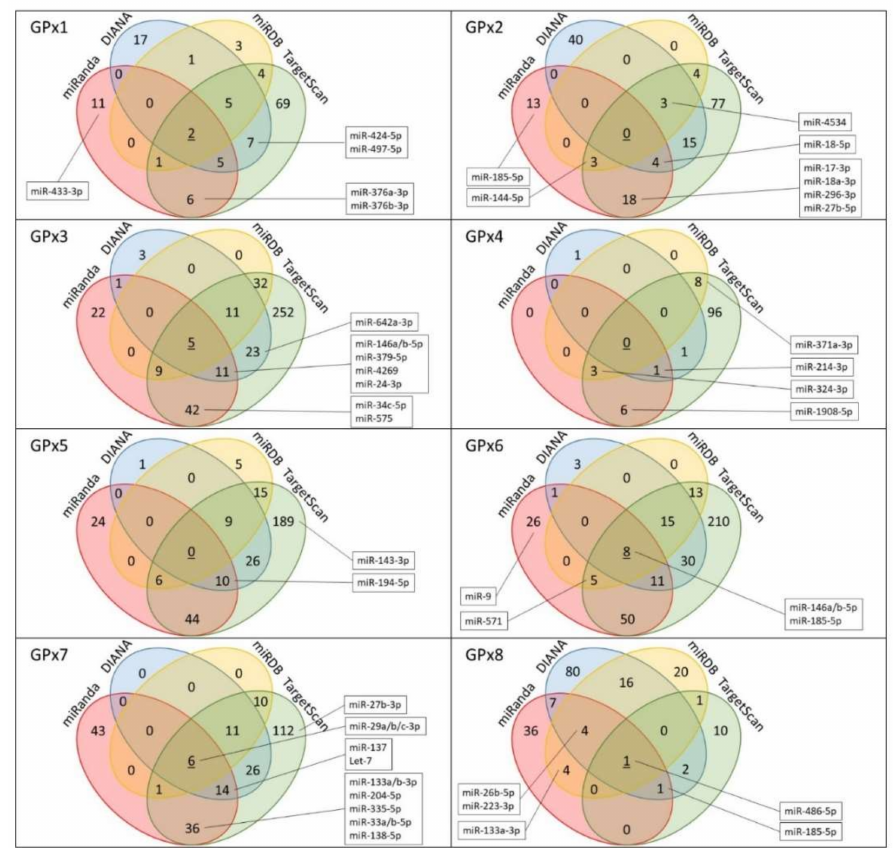
Figure 2. The Venn diagrams representing the number of microRNAs predicted to target GPxs identified by each program used. Identified microRNAs in boxes have reported connection to oxidative stress and